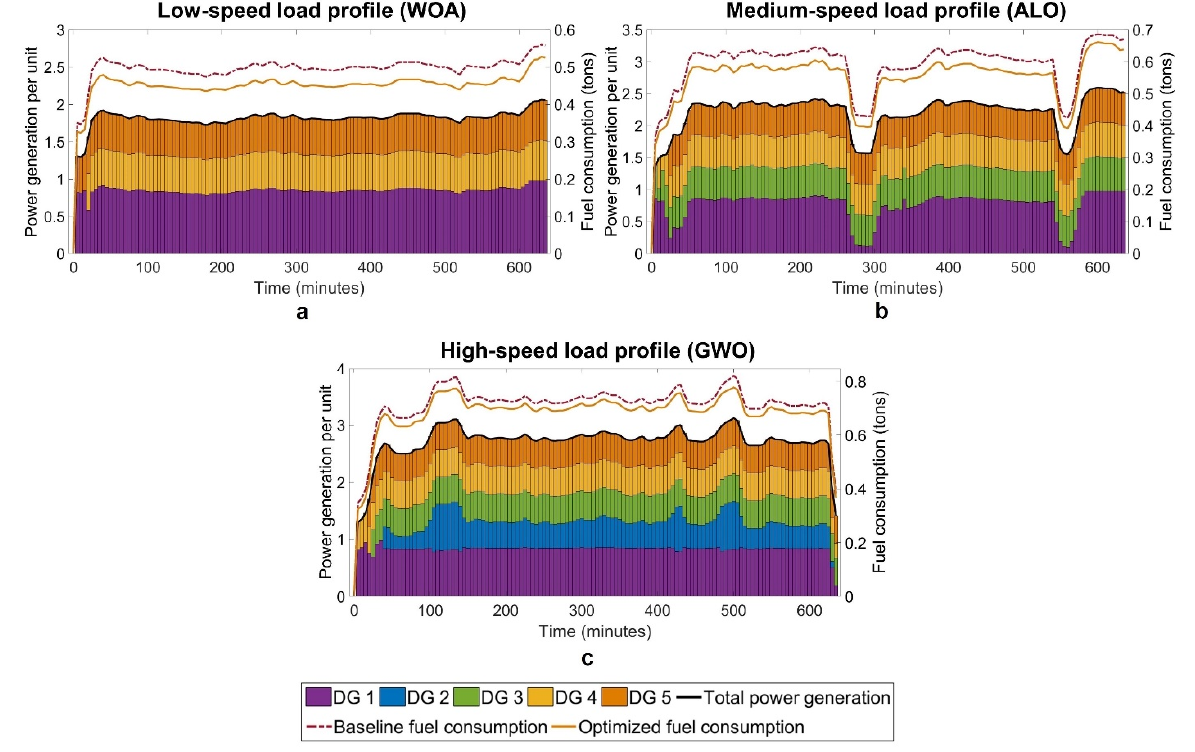
Figure 12. Optimization of the 5-DG system by using novel algorithms: ( a ) WOA with low-speed profile ( b ) ALO with medium-speed profile ( c ) GWO with high-speed profile.